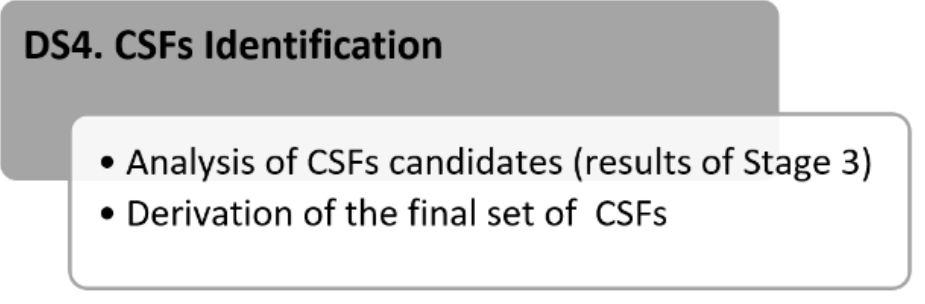
Figure 5. Design of CSFs: Stage 4.